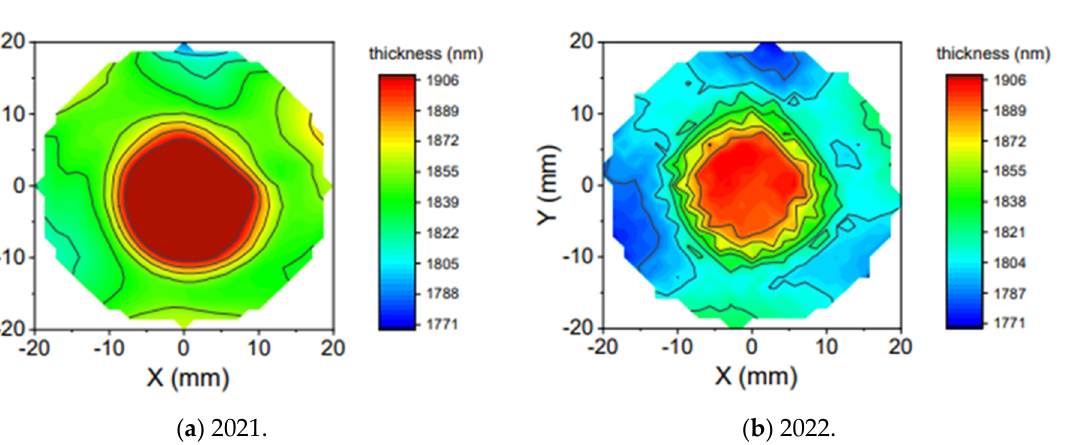
Figure 17. R p coefficient as a function of the direction Y, as indicated by the pink line (X = 0 mm) drawn in Figure 15a.